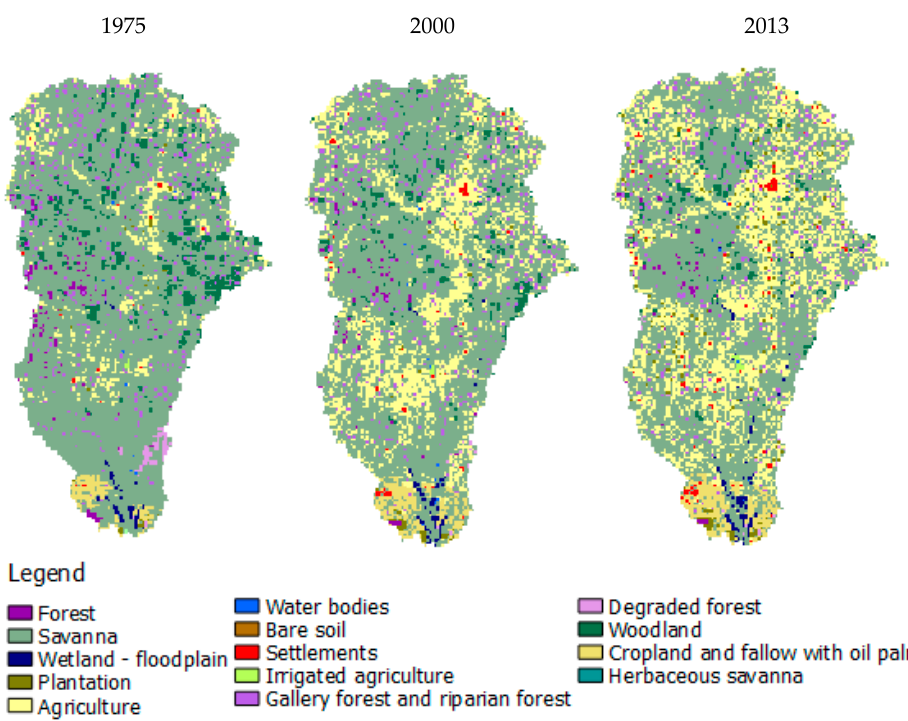
Figure 4. Land use and cover change from the years 1975, 2000 and 2013. Table 1. Percentage of change in land use and land cover within 1975–2000 and 2000–2013. Land Use